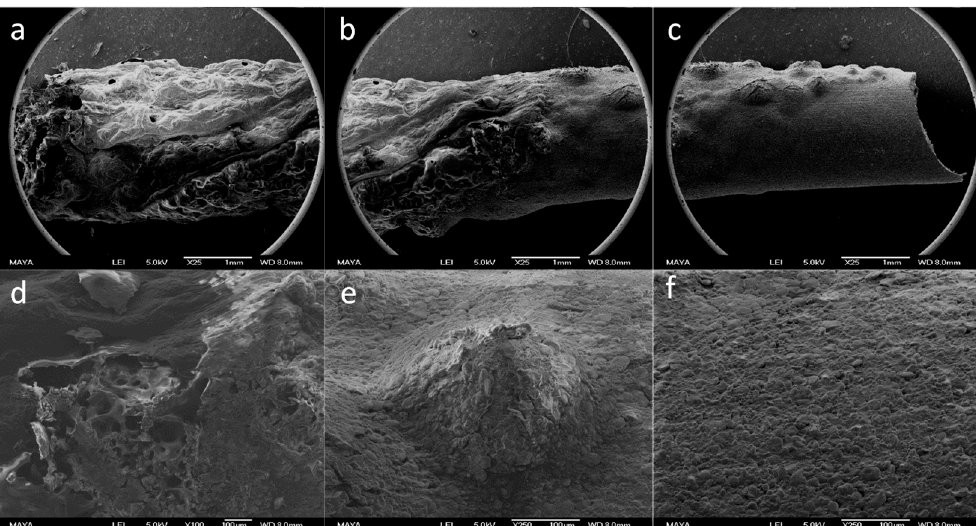
Figure 11. ( a ) to ( c ): SEM images taken at 5kV showing regions along a stick that have undergone different stages of combustion, all with a scale marker of 1 mm: ( a ) burnt end; ( b ) transition region; and ( c ) transition (upper left) and unburned material (lower right). ( d , f ) show details, all with scale marker 100 µm ( d ) from the broken surface of the partially burned stick; ( e ) transition region, and ( f ) unburned material.